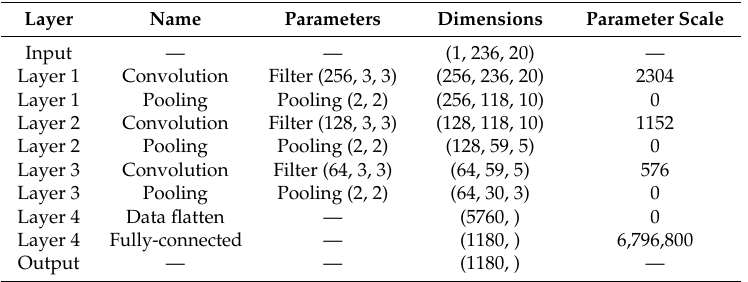
Table 2. Hyperparameters of the